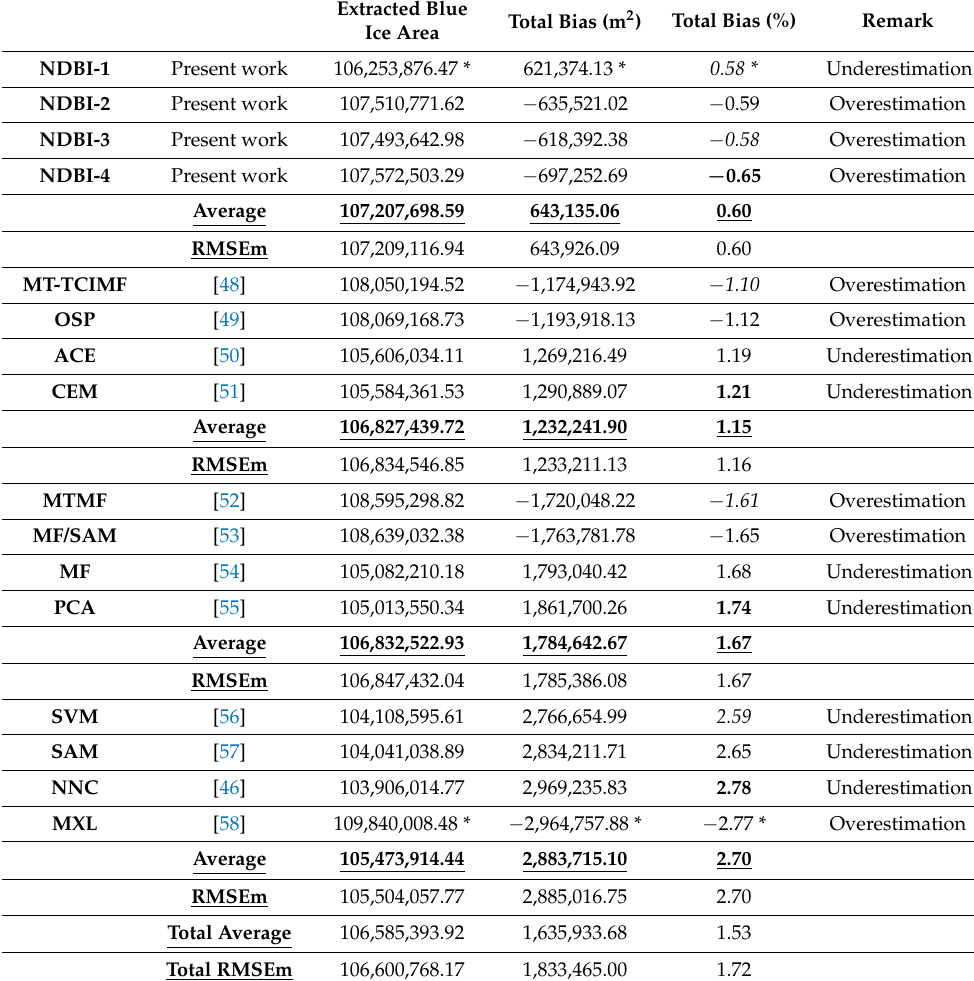
Table 8. Quantitative evaluation (bias, % and m 2 ) of various feature extraction methods for extracting blue ice from the entire study area. The lowest (italics) and highest (bold) values in each local column are highlighted. The column-wise average values are bolded and underlined. Total bias represents the total misclassified blue ice area in % and m 2 . Local outliers are highlighted using